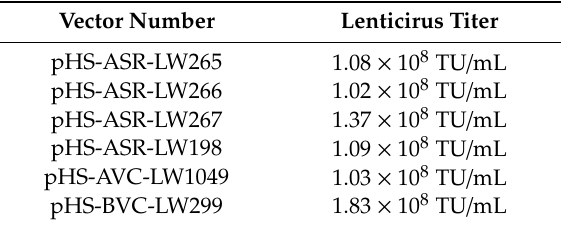
Table 2. Detection results of lentivirus titer.